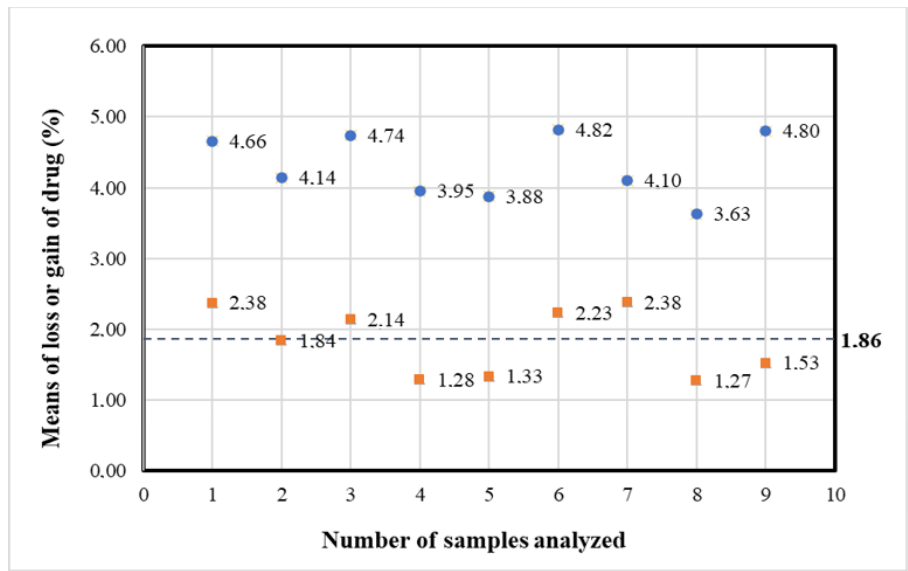
Figure 14. Percent loss of azacitidine relative to the initial experimental concentration value (red points), and the initial theoretical concentration (blue points) in nine samples at 48 h. The dotted line represents the maximum 1.86% loss (relative to the initial experimental concentration) identified as the maximum acceptable change of concentration.